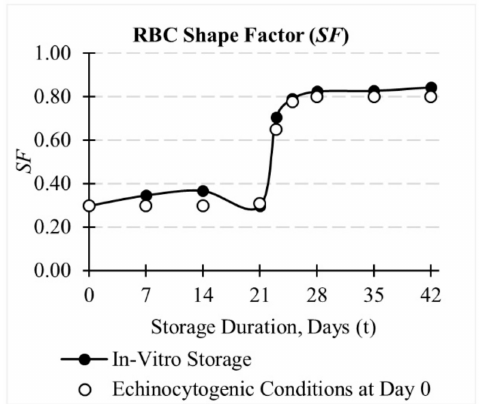
Figure 5. Shape factors ( SF ) of CG-RBC membrane model-predicted RBC morphologies during in-vitro storage (discocyte at 0 ≤ t < 20; echinocyte I at 20 ≤ t < 22; echinocyte II at 22 ≤ t < 24; echinocyte III at 24 ≤ t < 26; and sphero-echinocyte at 26 ≤ t ≤ 42), and at echinocytic shape-transforming